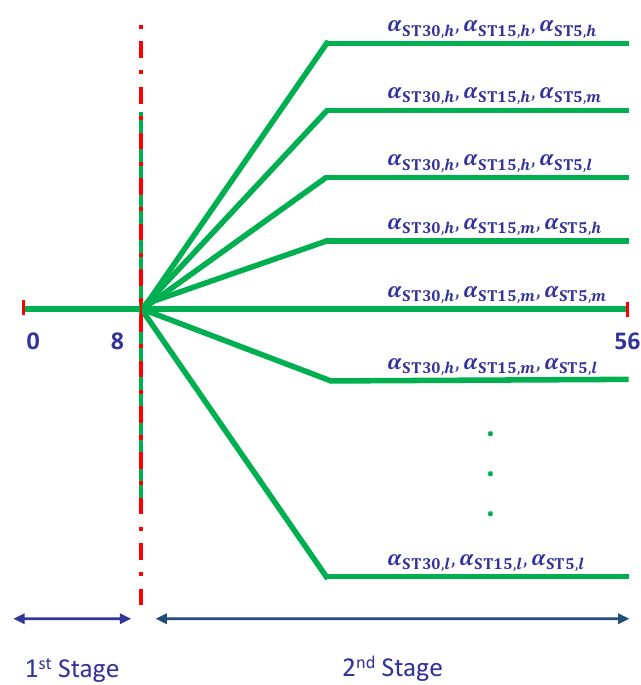
Figure 8. The scenario tree of the uncertain steam demands. In each scenario the dynamic nom- inal demand trajectory of steam network d , which is calculated based on the currently available information, is multiplied with the corresponding multiplication factor α d , i